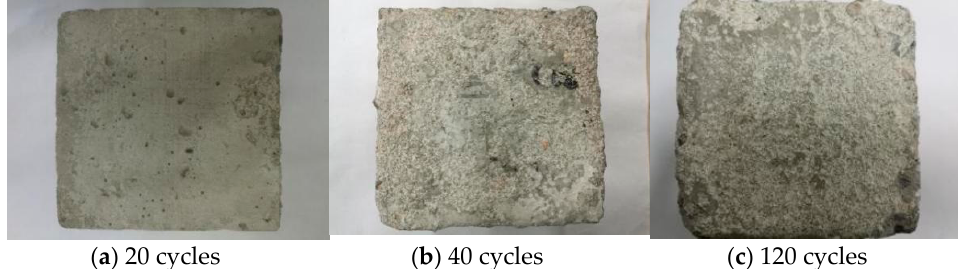
Figure 14. Macro morphology of concrete in the MgSO 4 solution.